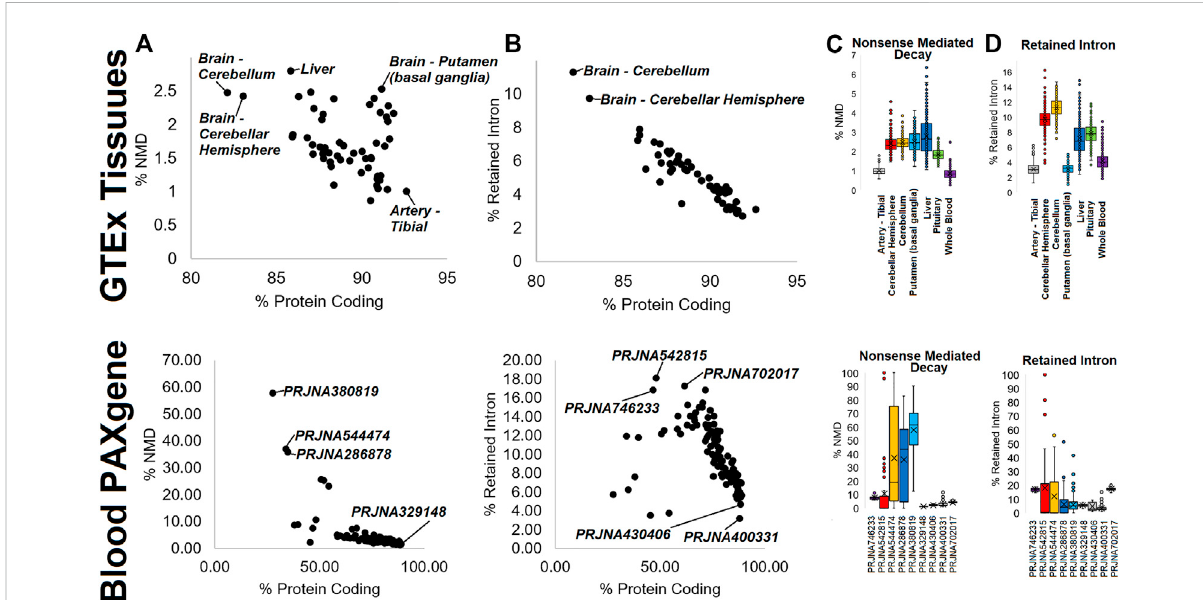
FIGURE 7 Biotype annotations in mapping data. The top four panels show data for GTEx, while the bottom four panels show data for “ Blood PAXgene. ” (A,B) Analysis for each tissue of GTEx (top) or BioProject of the SRA (bottom) for the percent of a small GTPase genes expression for protein-coding ( x -axis) vs. either nonsense-mediated decay (NMD, (A) or retained intron isoforms (B) . (C,D) Box and whisker plot for several outlier tissues (top) or BioProjects (bottom) of % of isoforms for each gene mapping to nonsense-mediated decay (C) or retained intron (D)